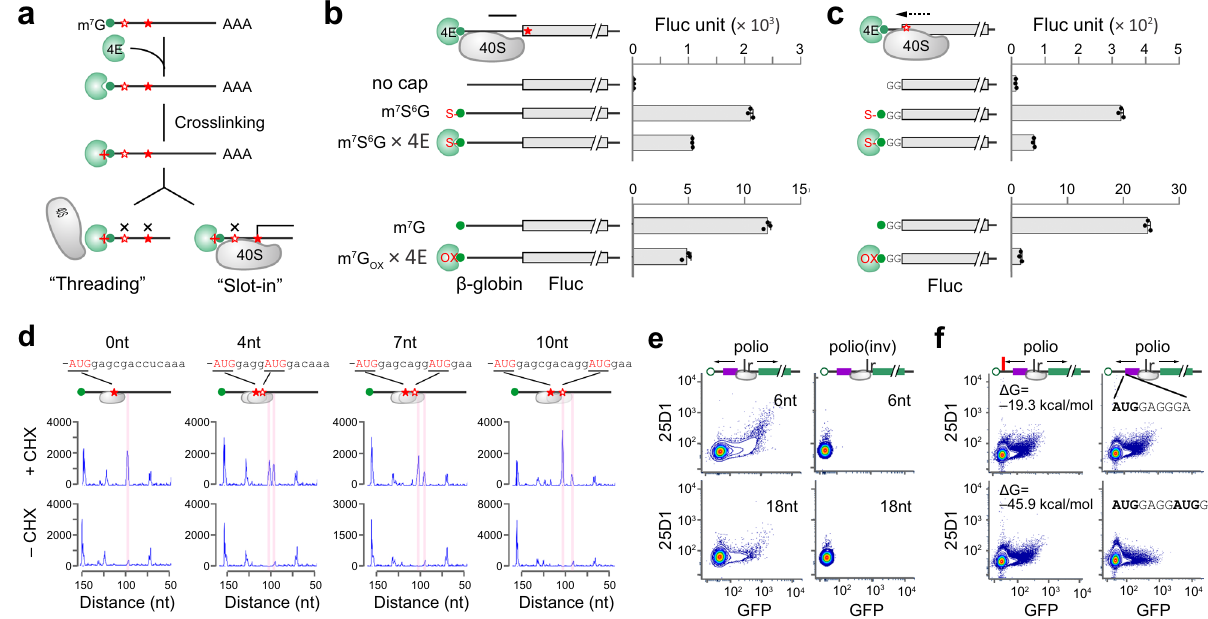
Fig. 2 Bi-directional PIC scanning contributes to start codon selection. a Schematic of cross-linking between m 7 G cap and eIF4E. Tethering eIF4E to m 7 G cap will prevent start codon selection in the ‘ threading ’ model, while permitting recognition of start codon downstream of the ‘ blind spot ’ in the ‘ slot-in ’ model. b Translational effects of cross-linking between m 7 G cap and eIF4E using Fluc mRNAs with β -globin 5 ʹ UTR. The top panel used m 7 s 6 G capped mRNAs followed by cross-linking under UV 360 nm. The bottom panel used redox reactions for cross-linking. In vitro translation was conducted in RRL and Fluc activities were monitored by luminometry. Error bars; mean ± SEM; n = 3 biological replicates. c Translational effects of cross-linking between m 7 G cap and eIF4E using Fluc mRNAs with ultra-short 5 ’ UTR (2 nt). The top and bottom panels are similar to ( b ). Error bars; mean ± SEM; n = 3 biological replicates. d Selection of closely spaced AUG codons by toe-printing assays. Two AUG codons with identical fl anking sequences but different length of the spacer were inserted into Fluc mRNAs with β -globin 5 ’ UTR. Expected positions corresponding to the ribosome leading edge are highlighted. The results are representative of three biological replicates. e Selection of start codons fl anking the IRES. The polio IRES was inserted between the uORF encoding SIINFEKL and GFP with 6 nt or 18 nt downstream of the uORF stop codon. The mRNA reporters were capped with non-functional ApppG. The fl ow cytometry scatterplots of HEK293-K b cells transfected with mRNA reporters are representative of three biological replicates. f For the mRNA reporters as in ( e ), a stem loop with different stability was placed near the 5 ʹ end (left panel) or an out-of-frame AUG was inserted downstream of the main AUG. The fl ow cytometry scatterplots of HEK293-K b cells transfected with mRNA reporters are representative of three biological replicates. Source data are provided as a Source Data fi